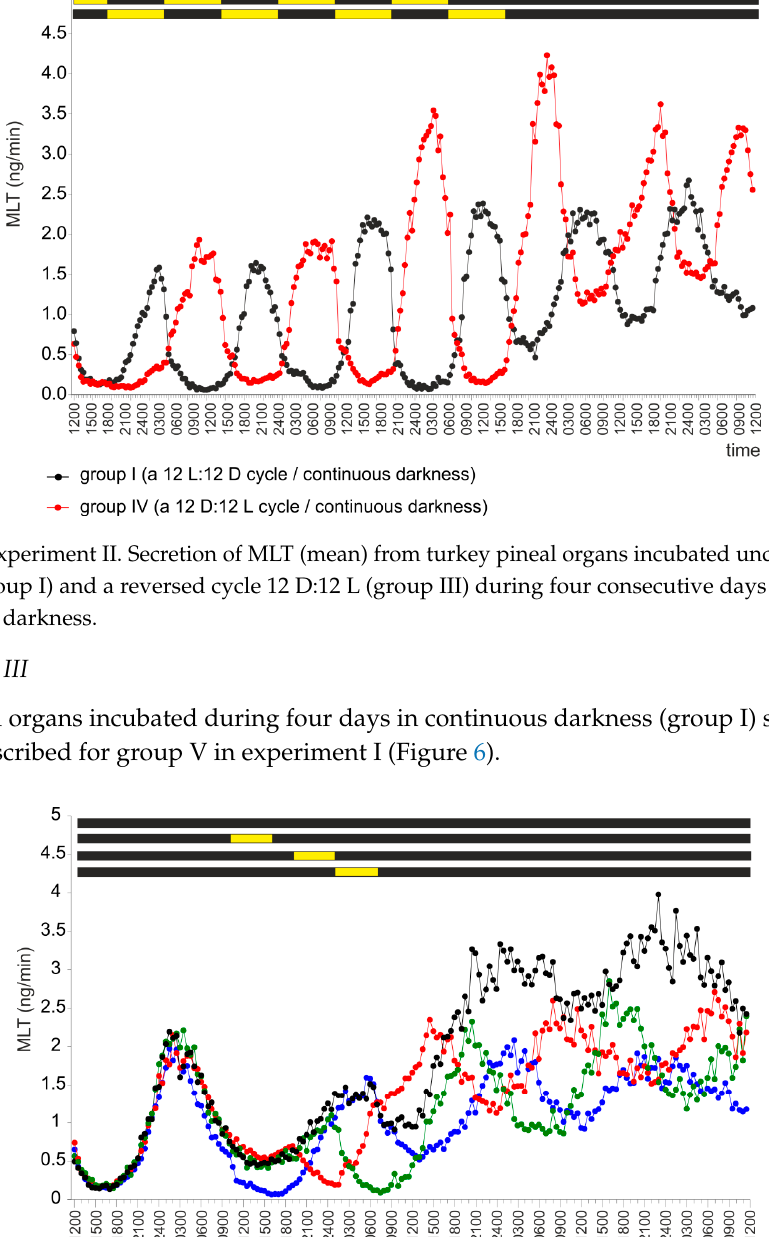
Table 2. Duration of increased MLT secretion during the scotophase or subjective night (mean, time clock presented in the format “hh.mm”; the standard error in minutes). The values labeled with different letters differ significantly (between groups) by the Duncan test ( p ≤ 0.05). n.d.—not determined.